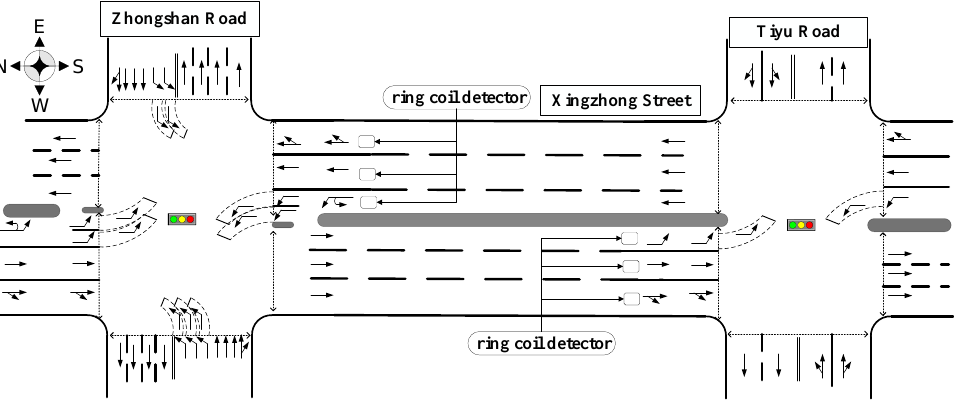
Figure 3. The layout of pilot intersections in the city of Zhongshan, China.